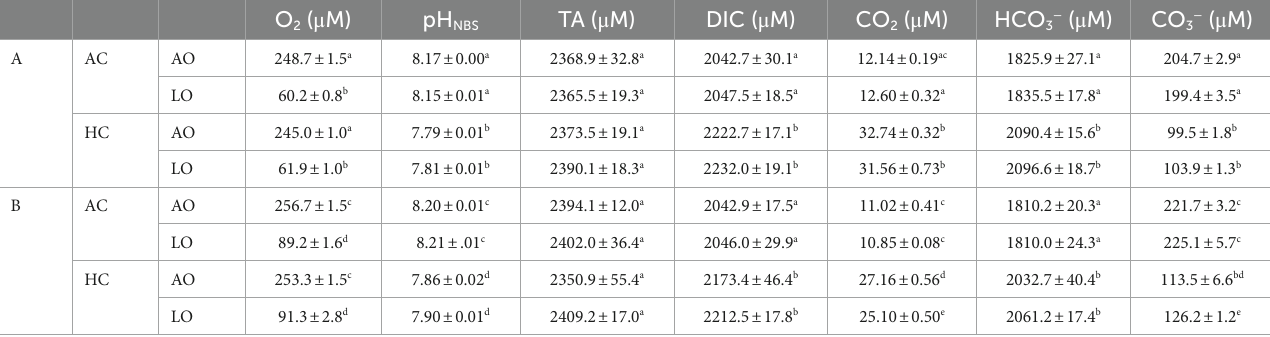
TABLE 1 Dissolved O 2 concentrations and carbonate chemistry parameters of the culture media during the semi-continuous cultures of Trichodesmium erythraeum IMS101 under the four treatments (ACAO, ~12 μ M CO 2 /~250 μ M O 2 ; ACLO, ~12 μ M CO 2 /~60 μ M O 2 ; HCAO, ~32 μ M CO 2 /~250 μ M O 2 ; HCLO, ~32 μ M CO 2 /~60 μ M O 2